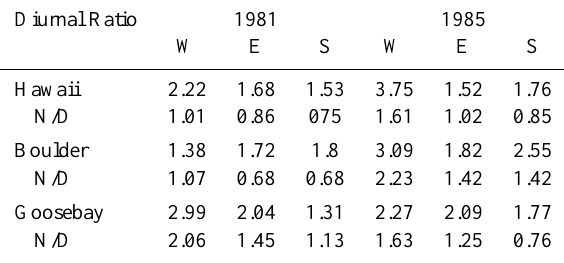
Table 3. Diurnal ratio and night/day (N/D) ratio of slab thickness for Hawaii, Boulder and Goosebay during the winter, equinox and summer seasons of the solar maximum year 1981 and solar minimum year